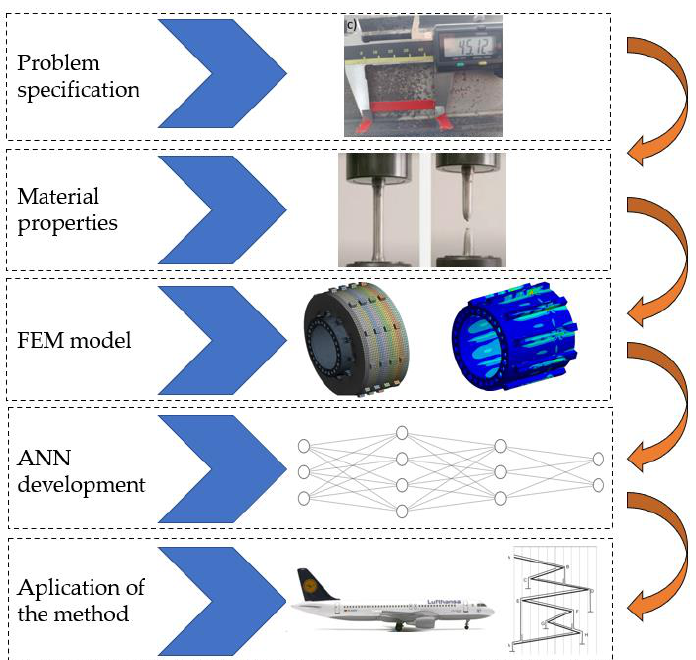
Figure 1. The method used ANN for stress prediction applied to ATT with future application to life-cycle counting.